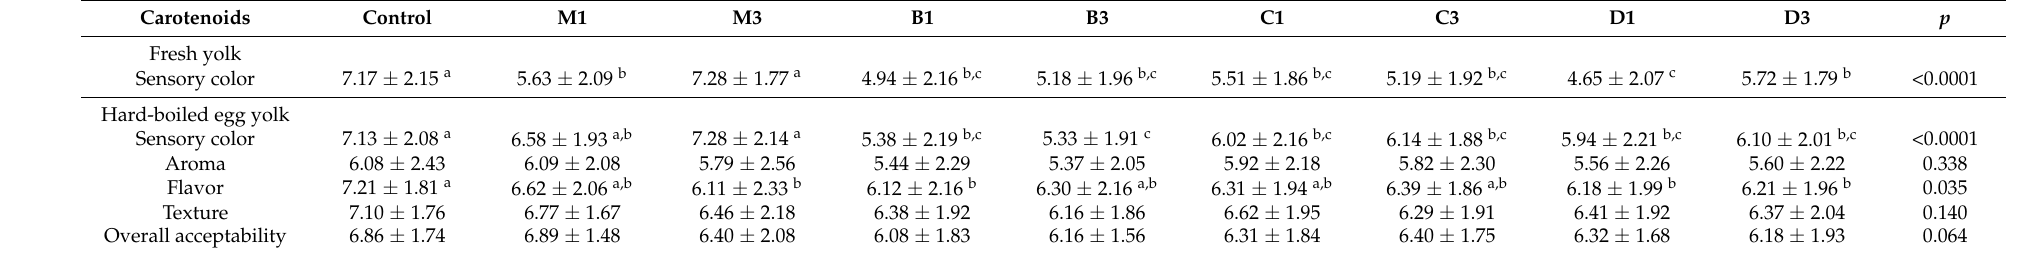
Table 5. Sensory traits (average ± SD) of fresh and hard-boiled egg yolks from hens differentiated in pigment supplementation (B1 and B3—1% and 3% basil herb; C1 and C3—1% and 3% calendula flower; D1 and D3—1% and 3% dandelion flower; and M1 and M3—1% and 3% marigold flower). Carotenoids Control Fresh yolk Sensory color Hard-boiled egg yolk Sensory